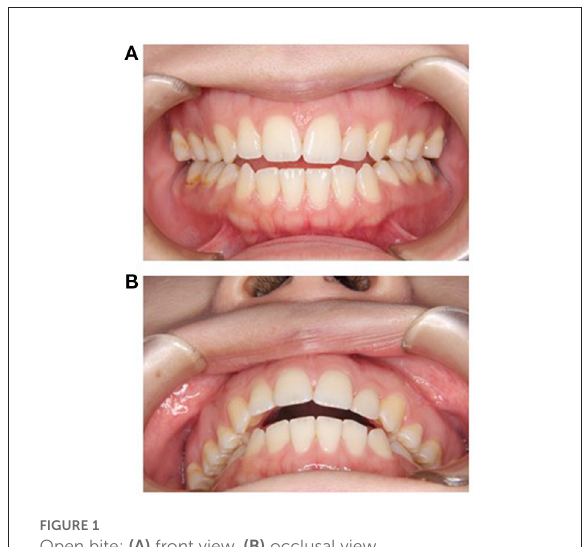
FIGURE1 Open bite: (A) front view, (B) occlusal